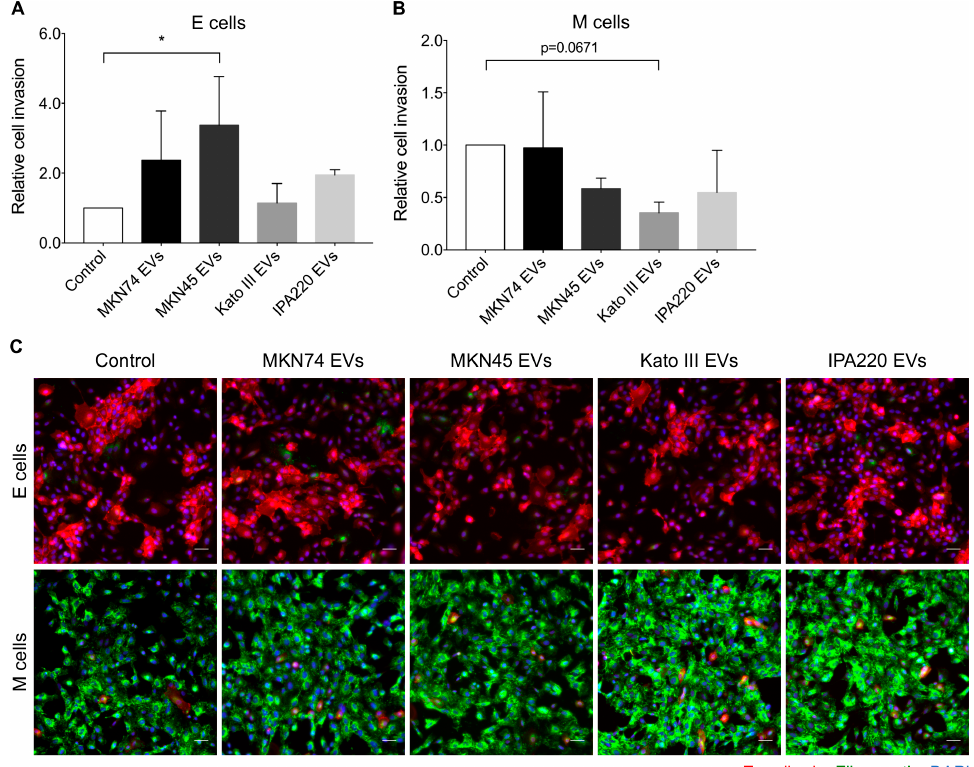
Figure 6. GC-EVs impair the invasion of epithelial and mesenchymal cells. The invasion levels of non-treated (control) and treated epithelial ( A ) or mesenchymal cells ( B ) were assessed by matrigel invasion assay; graph represents the mean ± standard deviation of three independent experiments and data was normalized to control cells (* p ≤ 0.05, one-way ANOVA with Kruskal-Wallis test); ( C ) immunofluorescence for E-cadherin (red staining) and fibronectin (green staining) in non-treated (control) and treated epithelial and mesenchymal cells. Scale bars: 50 µ